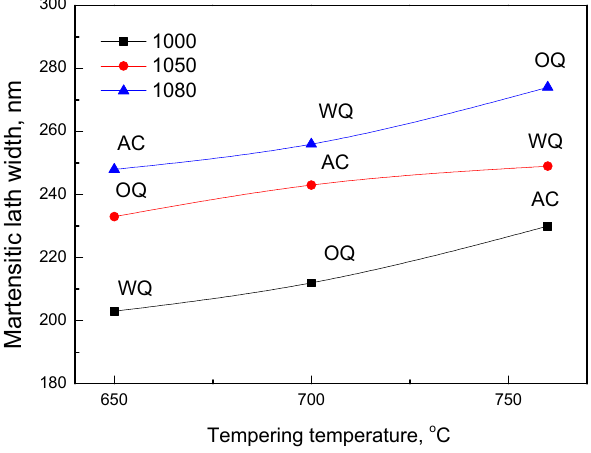
Figure 4. Average martensitic lath width of 15Cr12MoVWN steel according to heat treatment parameters.